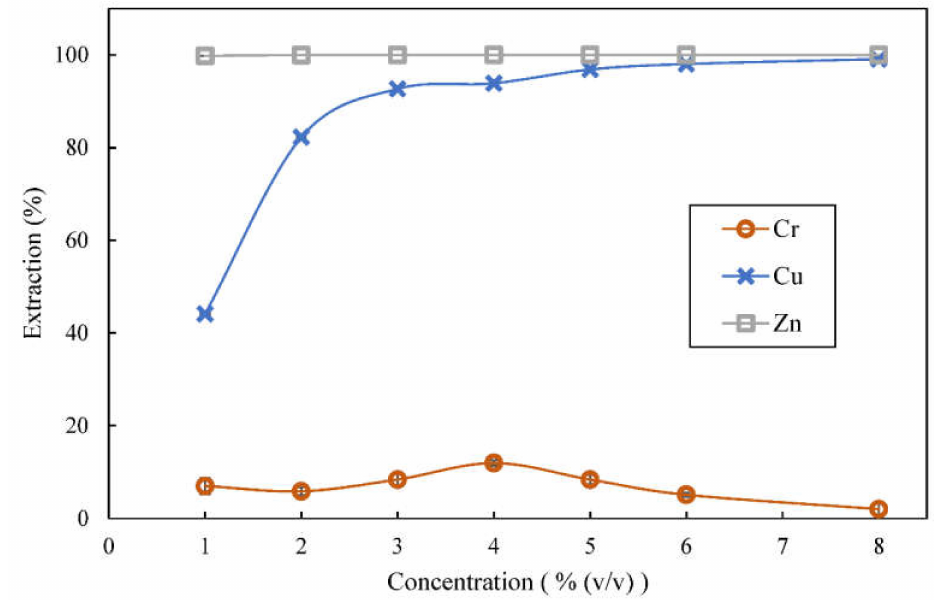
Figure 5. Effect of concentration of D2EHPA on extraction of metal ions from feed containing 100 ppm chromium (VI), copper and zinc in 0.1 mol/L acetate buffer; organic phase consisted of D2EHPA in